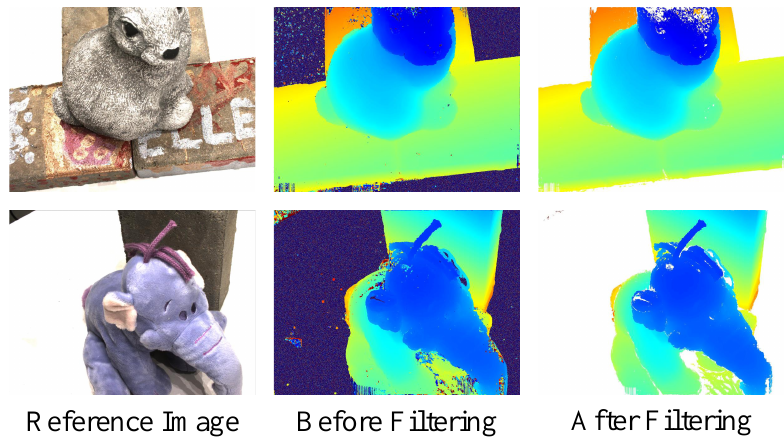
Figure 5. Semi-dense pseudo-label with cross-view geometric